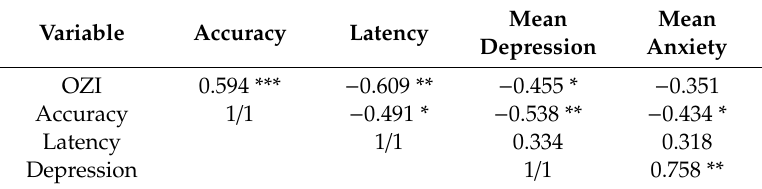
Table 2. Spearman correlations ( ρ ) of response time and vocabulary of 18-month-old children and mothers’ depression and anxiety scores.